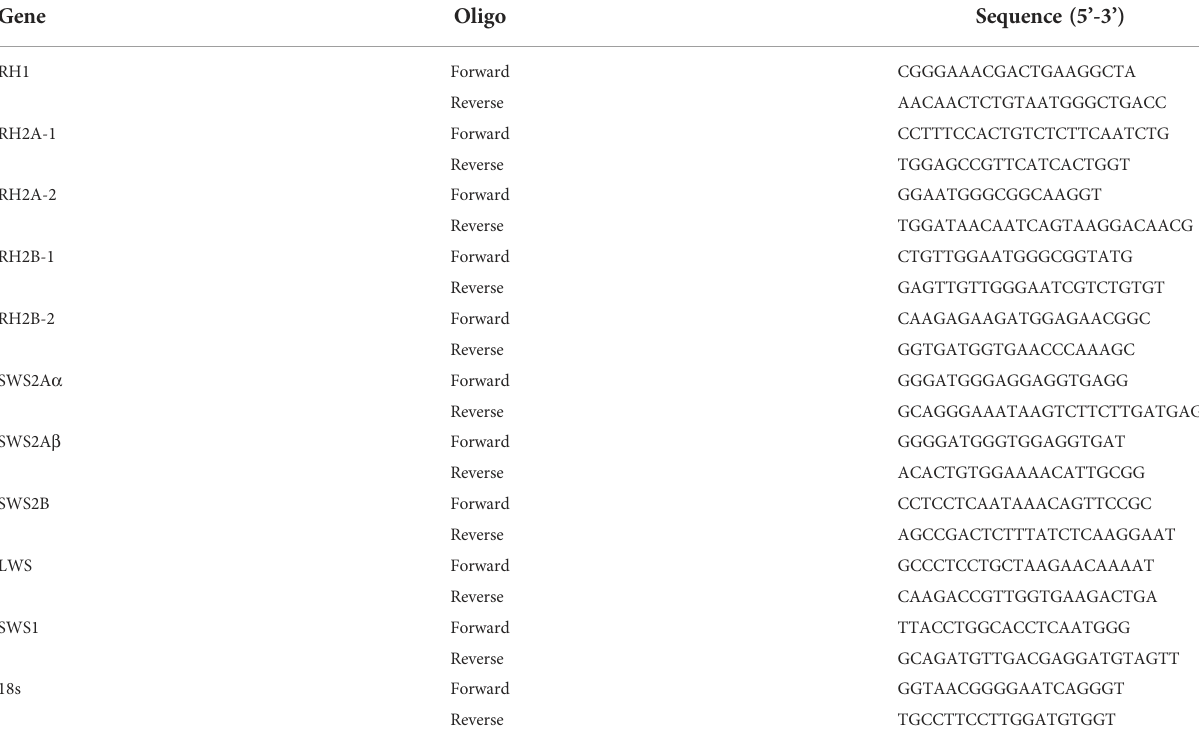
TABLE 1 Primers used for qPCR analyses in this